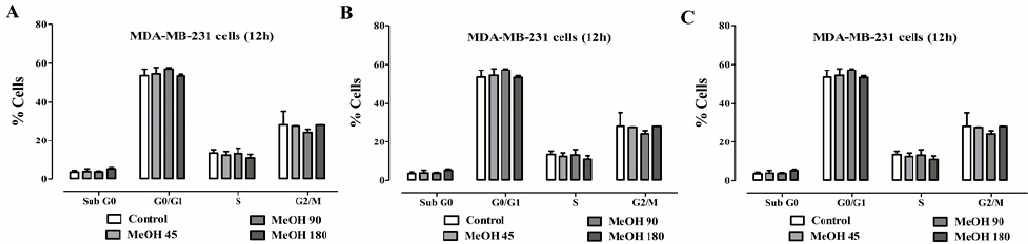
Figure 3. Effect of F. umbellata extracts on cell cycle distribution in MDA-MB-231 cells after different